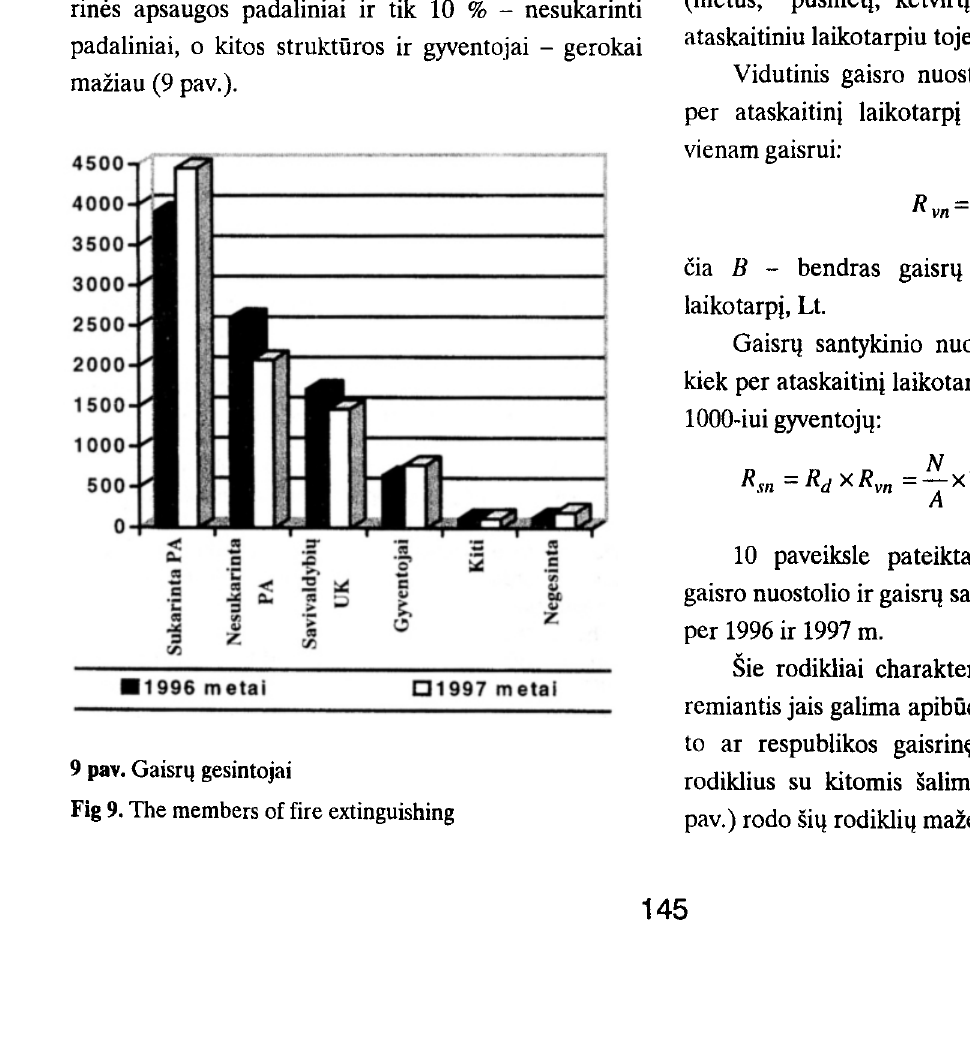
Fig 9. The members of fire